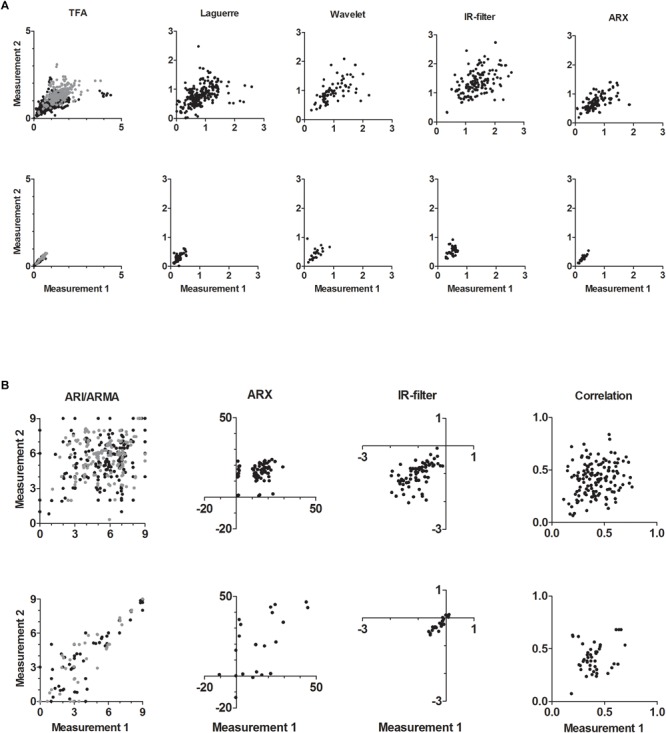
(A) Gain LF results of TFA-like methods for repeated measurements. Top row: physiological data, bottom row: surrogate data. For each method group (TFA, Laguerre, Wavelet, IR-filter, and ARX) the results of similar methods are combined (Table 1). TFA: black dots are 10 methods (cm/s/mmHg), gray dots are 3 methods (%/% or %/mmHg); Laguerre: 4 methods (cm/s/mmHg); Wavelet: 1 method (cm/s/mmHg); IR-filter: 2 methods (%/%); ARX: 2 methods (cm/s/mmHg). See Supplementary Figures S1–S3 for Phase VLF/LF and Gain VLF. (B) ARI-like results of different methods for repeated measurements. Top row: physiological data, bottom row: surrogate data. For each method group (ARI/ARMA, ARX, IR-filter, and correlation) the results of similar methods are combined (Table 1). ARI: black dots are three methods (ARI 0–9 arbitrary units); gray dots are two methods (ARMA-ARI 0–9 arbitrary units); ARX: one method (ARX coefficient); IR-filter: one method (arbitrary units); correlation: two methods.